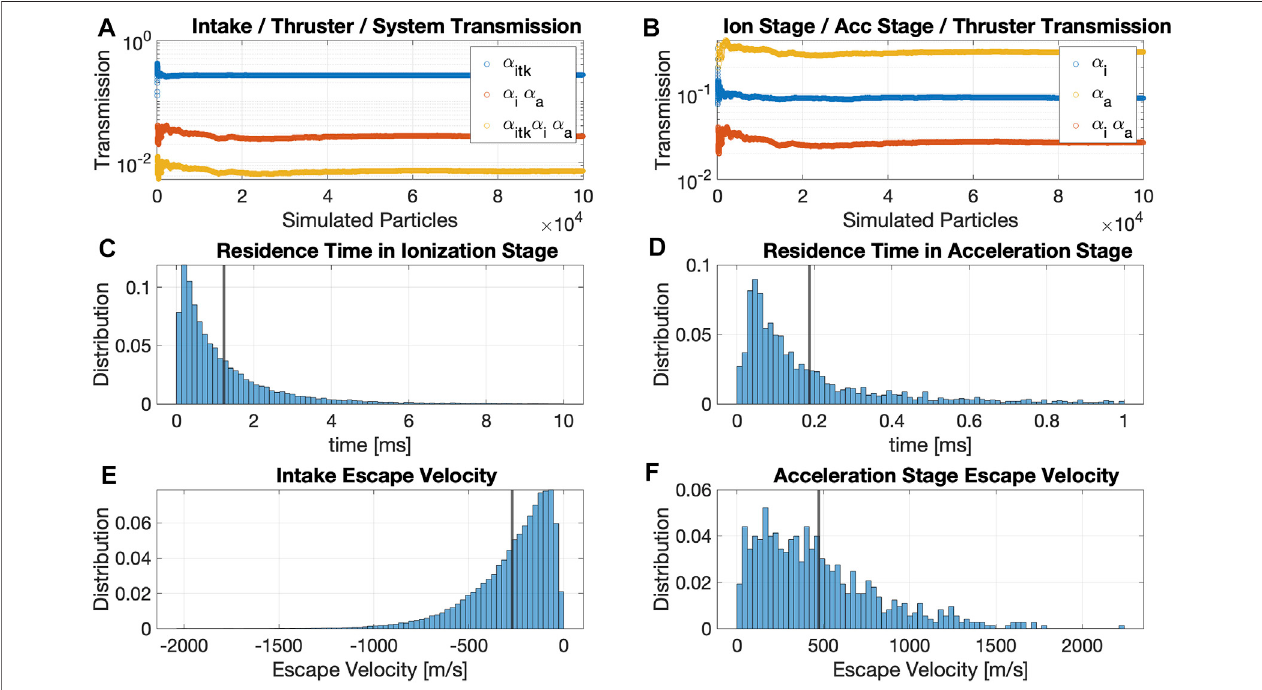
FIGURE8| NeutralMonteCarlooutputforareferenceintaketestcaseand1e5simulatedN 2 particles.TheRam-EPthrusterisintheOFFstate. (A) Intake,thruster, and system transmissions; (B) ionization stage, acceleration stage, and thruster transmissions; (C) residence time distribution in the ionization stage control volume; (D) residence time distribution in the acceleration stage control volume; (E) intake escape velocity distribution; (F) acceleration stage escape velocity distribution.